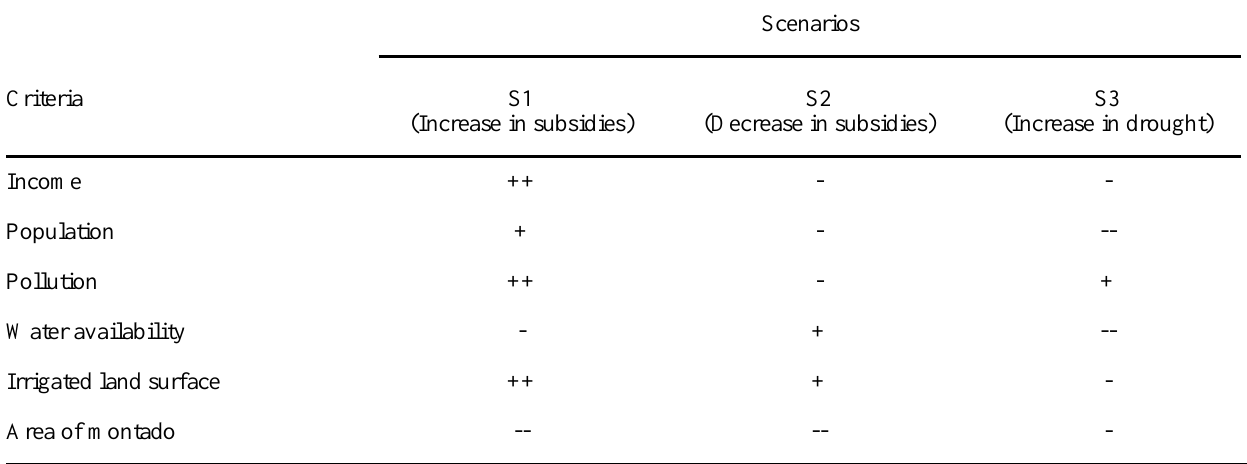
Table 1. Comparison of scenarios